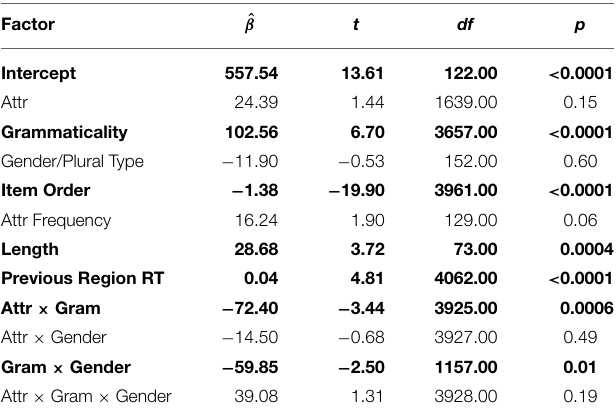
TABLE 3 | Table of coefficients for a linear mixed effects regression with gender/plural type for the critical verb region (R6).